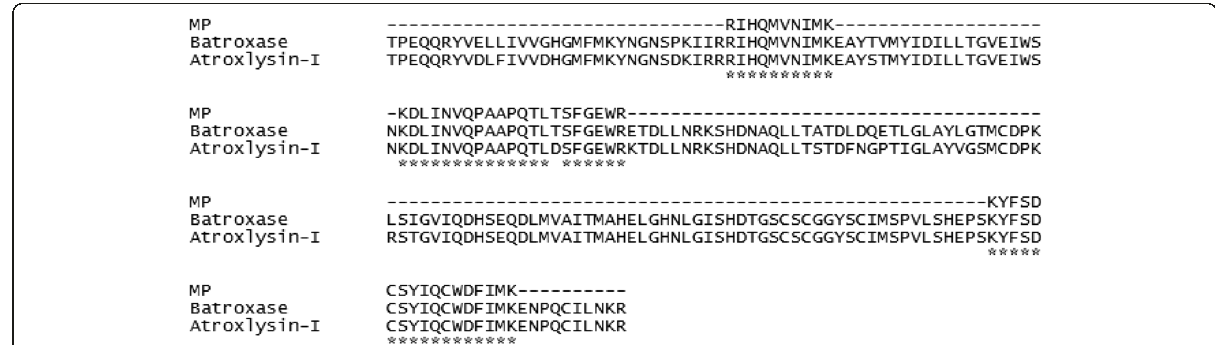
Fig. 7 Comparison of the partial amino acid sequence obtained for the MP from B. atrox venom with two other P-I metalloproteases previously isolated from the same venom: Batroxase and atroxlysin-I. Multiple sequence alignment was made using the program ClustalX v. 2.0.11. (*) indicates positions with fully conserved amino acid residues